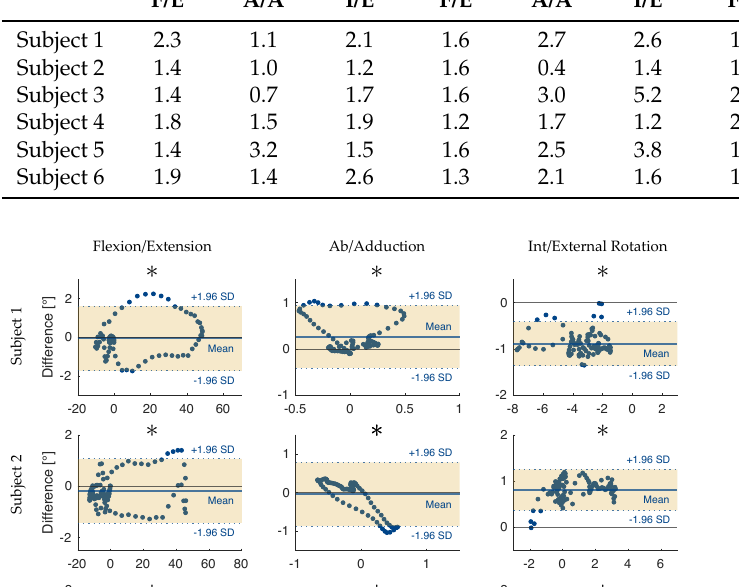
Table A2. Maximum absolute error (in degrees) between sensor-estimated kinematics and simulator- generated ground truth data over the same previously analysed cycle. Results are shown for all six subjects, for every activity type, in each of the three rotation planes. (F/E = flexion/extension; A/A = adduction/abduction; I/E = internal/external tibial rotation). Level Walking Stair Descent Sit-to-Stand-to-Sit F/E A/A I/E